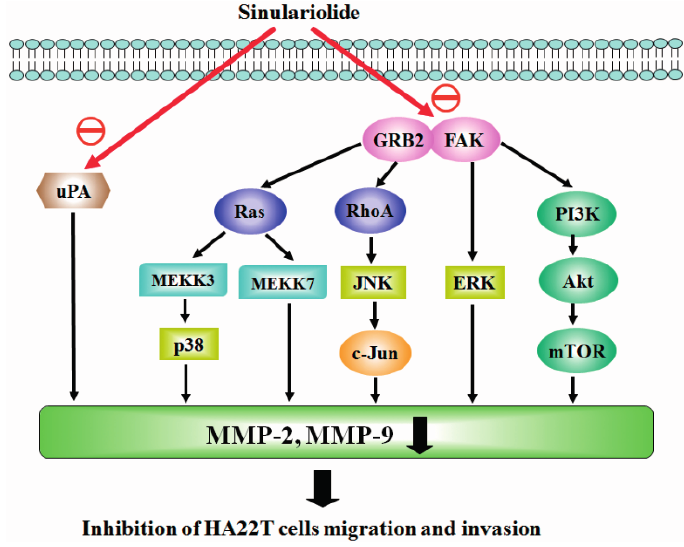
Figure 6. Proposed signaling pathways for sinulariolide-mediated inhibition of HA22T cell migration. The effect of sinulariolide is most likely achieved through the inhibition of FAK and GRB2, which regulates MMP-2/-9 expression through the MAPK and PI3K/Akt signaling pathways. Red arrows means sinulariolide inhibit the pathways. Black arrows means the upper molecules induced the following